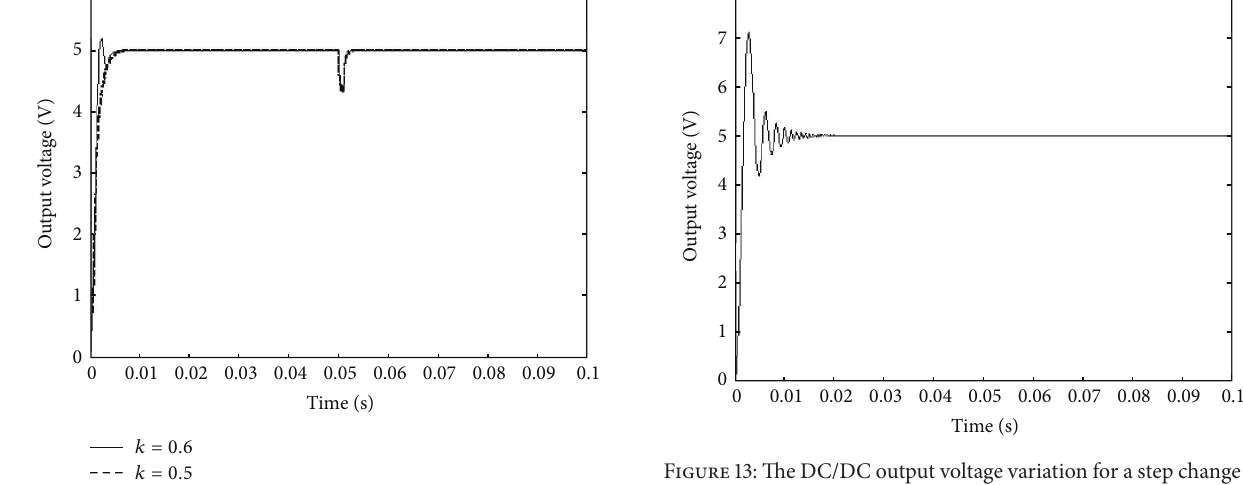
Figure 13: The DC/DC output voltage variation for a step change in line voltage in direct control method.